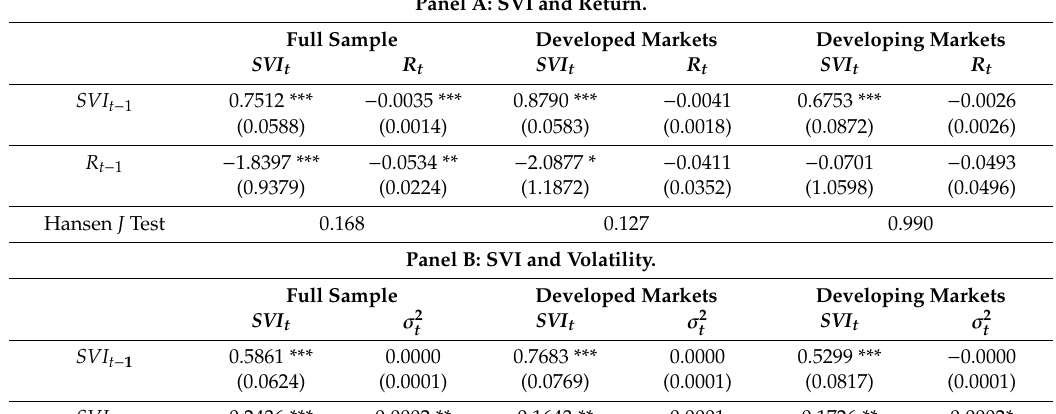
Table 2. Panel vector autoregression (VAR) estimations. Panel A: SVI and